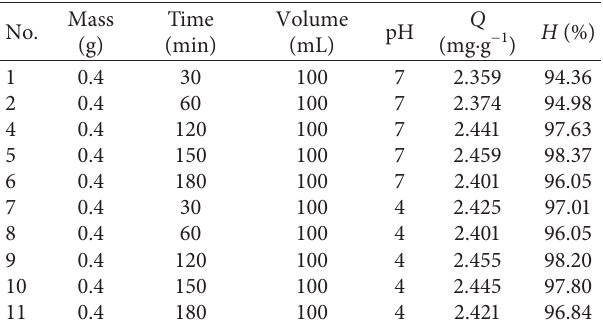
Table 12: Effect of adsorption time on methylene blue adsorption